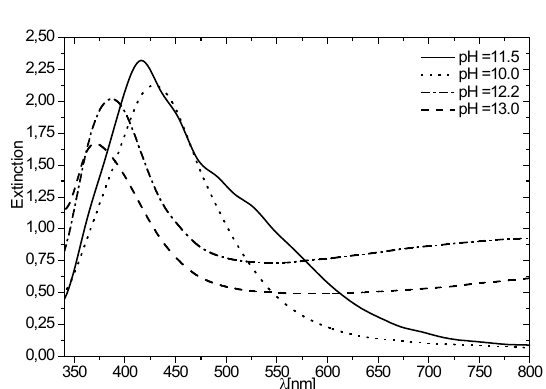
Figure 4. UV-Vis spectra recorded during the photoreduction of AgBr crystals in the presence of ascorbic acid, with an AgBr to ascorbic acid molar ratio of 1:3.0, various pHs and with exposition to light.